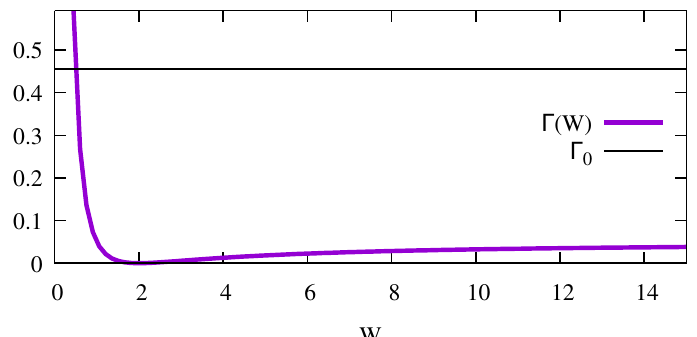
Figure 20: Effective potential Γ for the width W ( t ) [ see text and Eq. (59) ] for m = 1, = 2 and α = 1 / g = 1 / 4, A 0